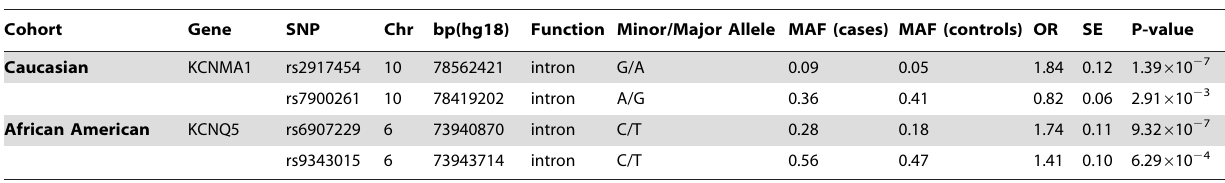
Table 4. Significantly associated SNPs in genes KCNMA1 and KCNQ5 .